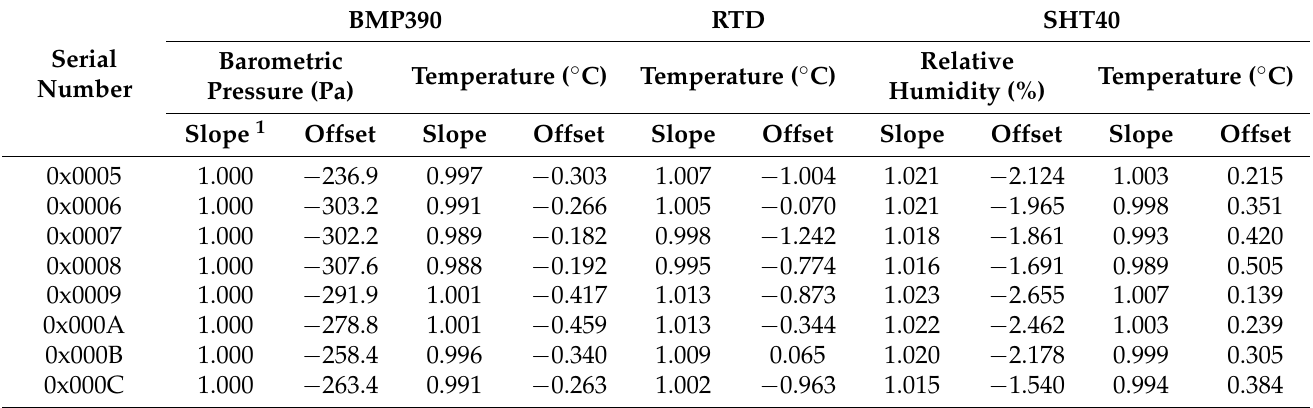
Table 6. Regression model coefficients for uncalibrated PTH probes.